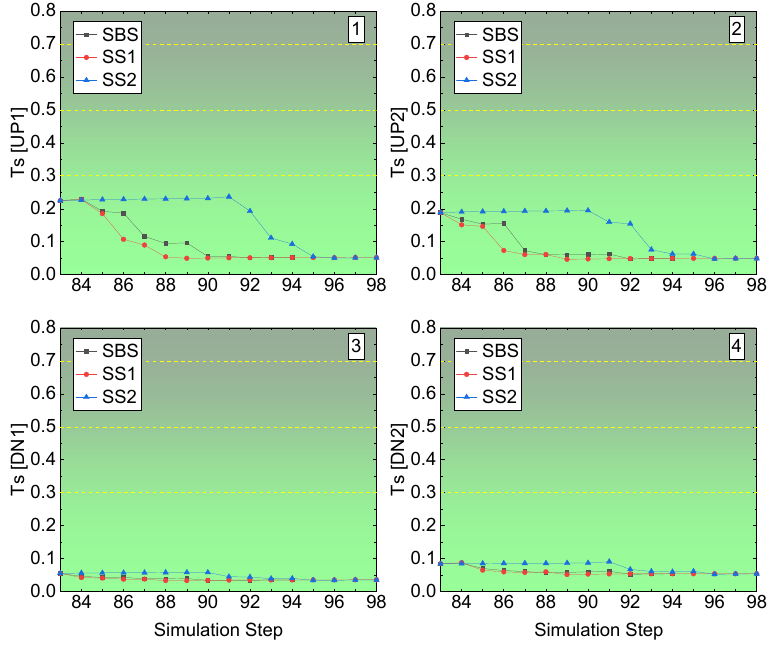
Figure 15. Ts value of the middle stope access to undercuts in Sill-1. The rockburst tendency of the four corners in the left-edge stope access to the undercut is illustrated in Figure 16. Like the middle stope access to undercut, there is no rockburst tendency in the four corners. While compared with the floor corners, the roof corners have high values of Ts. The floor corners have a Ts value under 0.05 among the three sill pillar recovery schemes. For the roof corners, UP1 and UP2, though the three sill pillar recovery schemes cause a different value of Ts, the Ts is under 0.2, and after the completion of the recovery and backfilling of the two sill pillars, the Ts values of the three sill pillar recovery schemes reach the same final state of Ts.